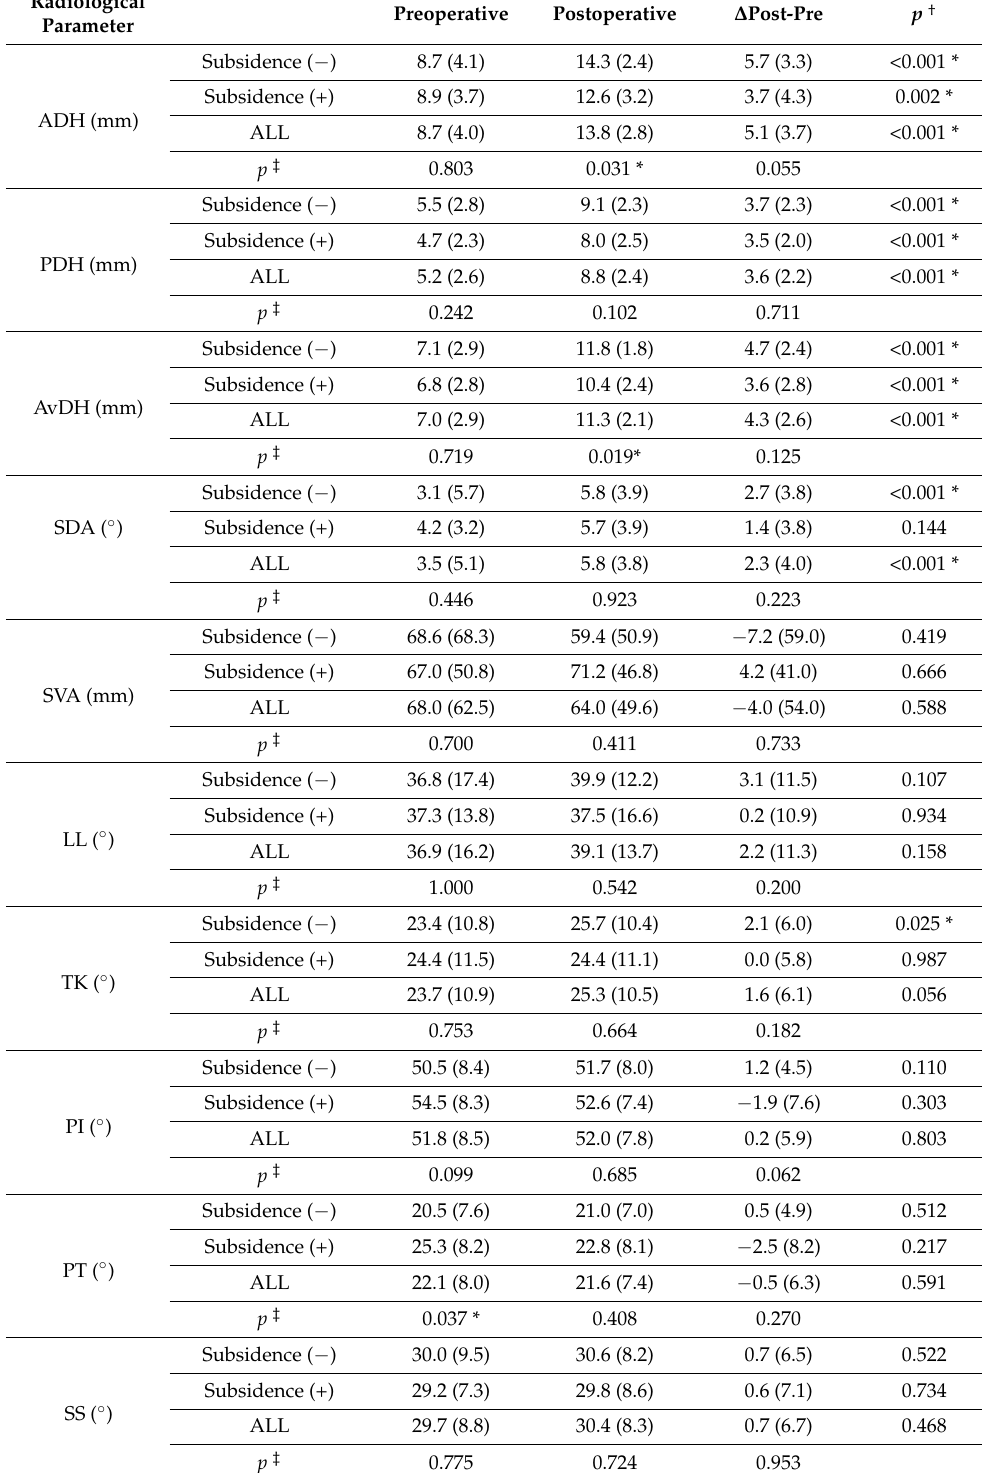
Table 4. Preoperative, postoperative, and change from pre- to postoperative sagittal measurements. Data presented as mean (SD) ADH, anterior disc height; PDH, posterior disc height; AvDH, average disc height; SDA, segmental disc angle; SVA, sagittal vertical axis; LL, lumbar lordosis; TK, thoracic kyphosis; PI, pelvic incidence; PT, pelvic tilt; SS, sacral slope † comparison with pre op ‡ comparison between groups * statistically